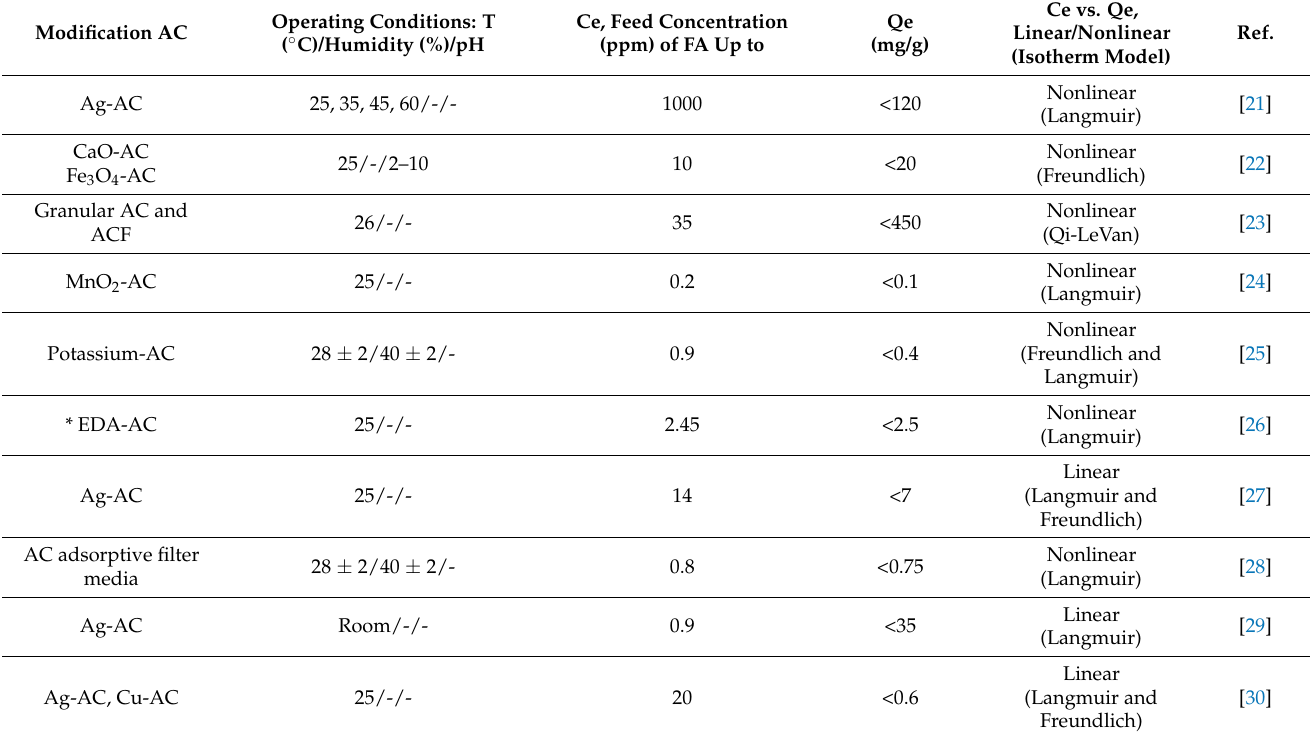
Table 2. Adsorption isotherms for formaldehyde on surface-modified AC as reported in the